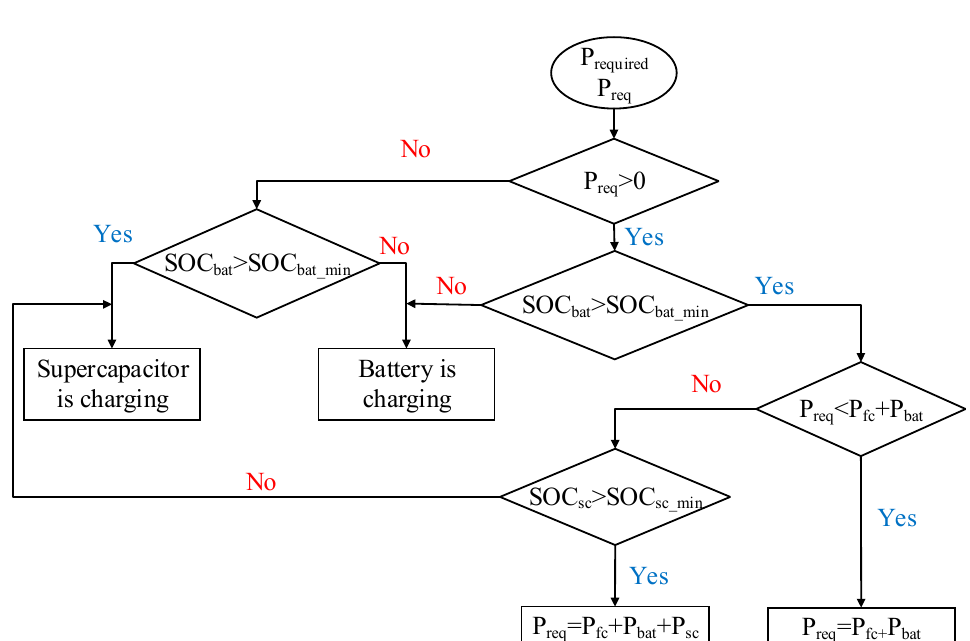
Figure 4. The flowchart of hydrogen fuel saving control strategy (HFS-CS) [18].